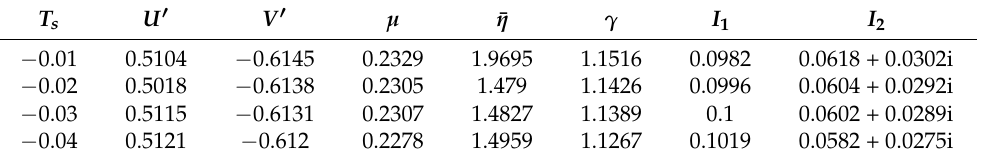
Table 2. Values of stability parameter for a rotating disk in axial flow T s < 0.